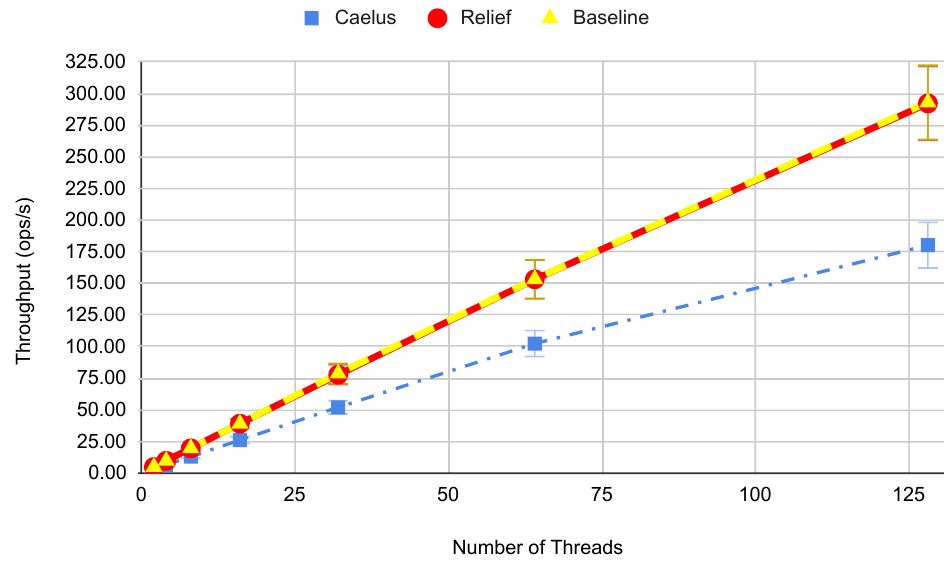
Figure 9. Relief throughput